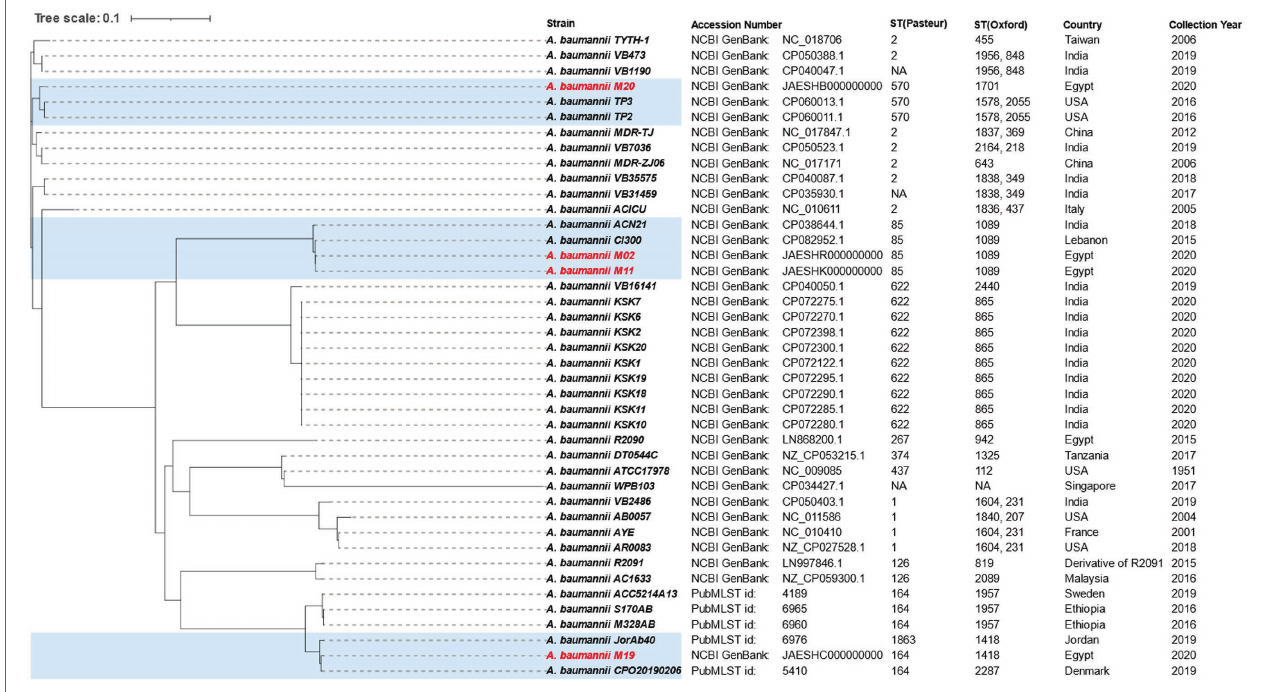
FIGURE 1 | A single nucleotide polymorphism-based phylogenetic tree depicting the genetic relatedness of bla NDM-1 -positive isolates sequenced in the current study to other Acinetobacter baumannii strains. A. baumannii strains sequenced in the current study together with their genetically related strains are highlighted by blue